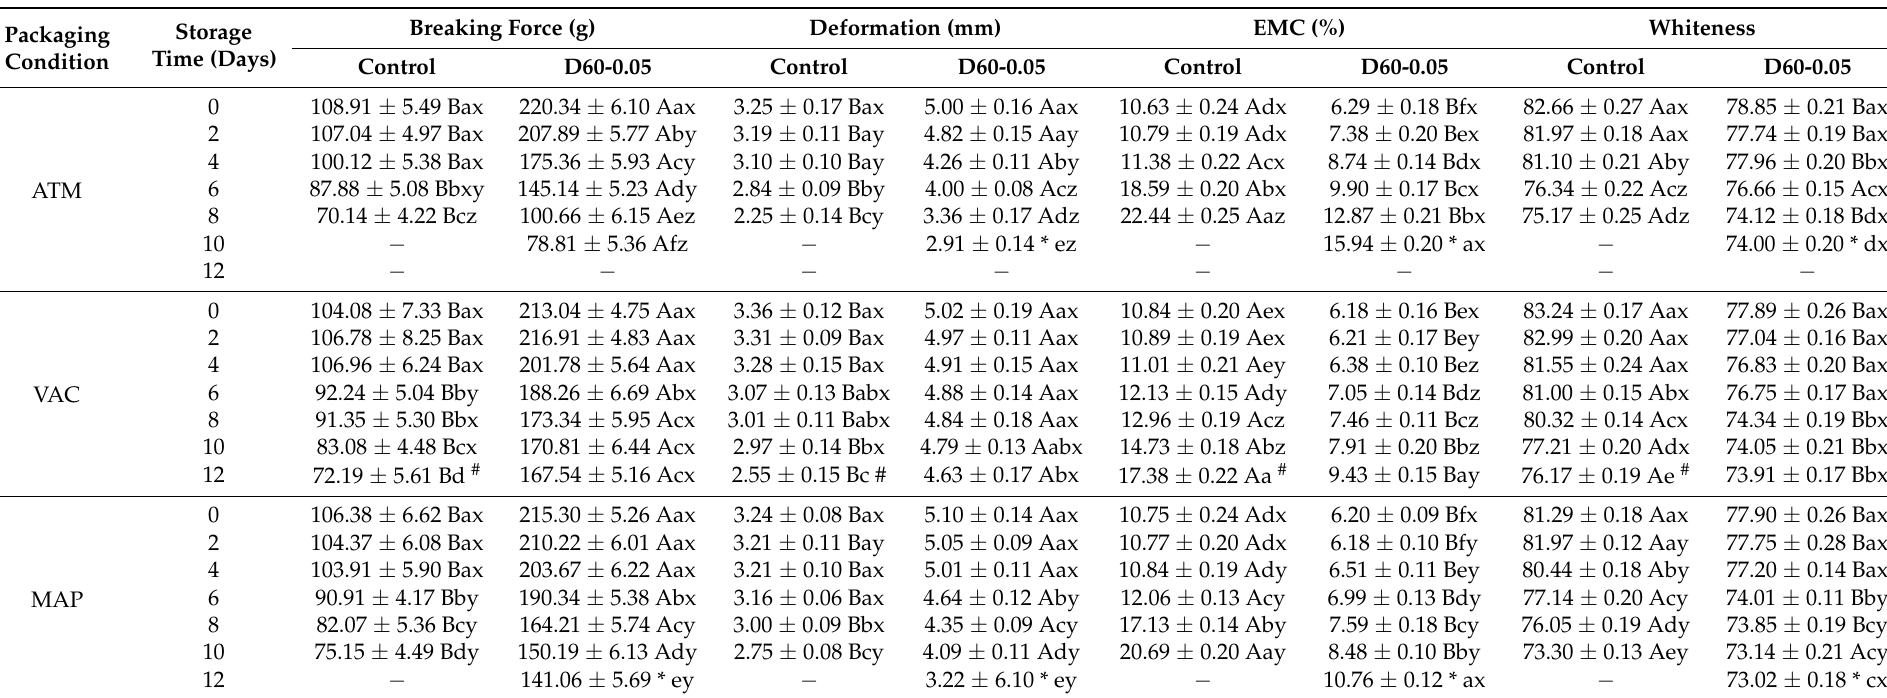
Table 6. Breaking force, deformation, expressible moisture content (EMC) and whiteness of the surimi gel without and with 0.05% DCE-60 added under different packaging conditions during refrigerated